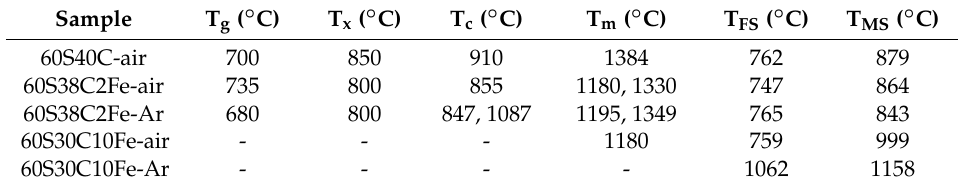
Table 2. Characteristic temperatures of the calcined materials determined (when possible) from DTA (T g , T x , T c and T m ) and HSM plots (T FS and T MS